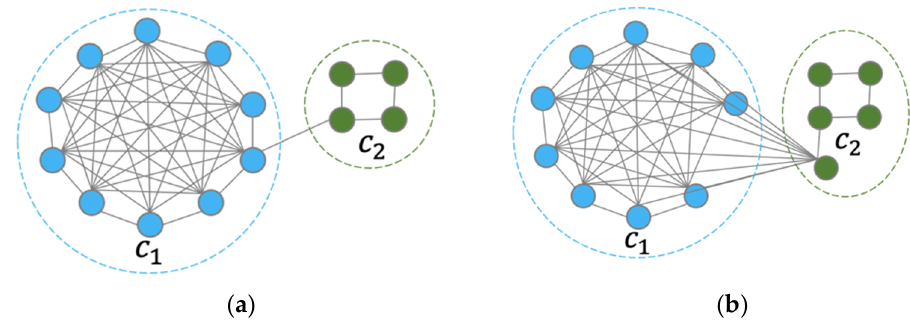
Figure 3. Modularity calculation method. ( a ) Community division 1; ( b ) Community division 2.